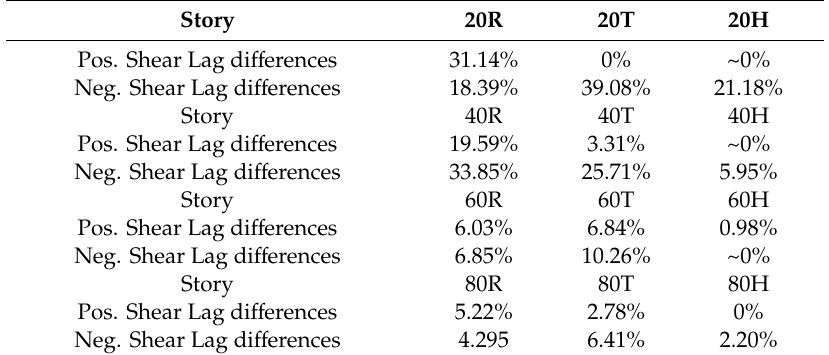
Table 3. The di ff erences between shear lag obtained from the wind load and dynamic earthquake load.